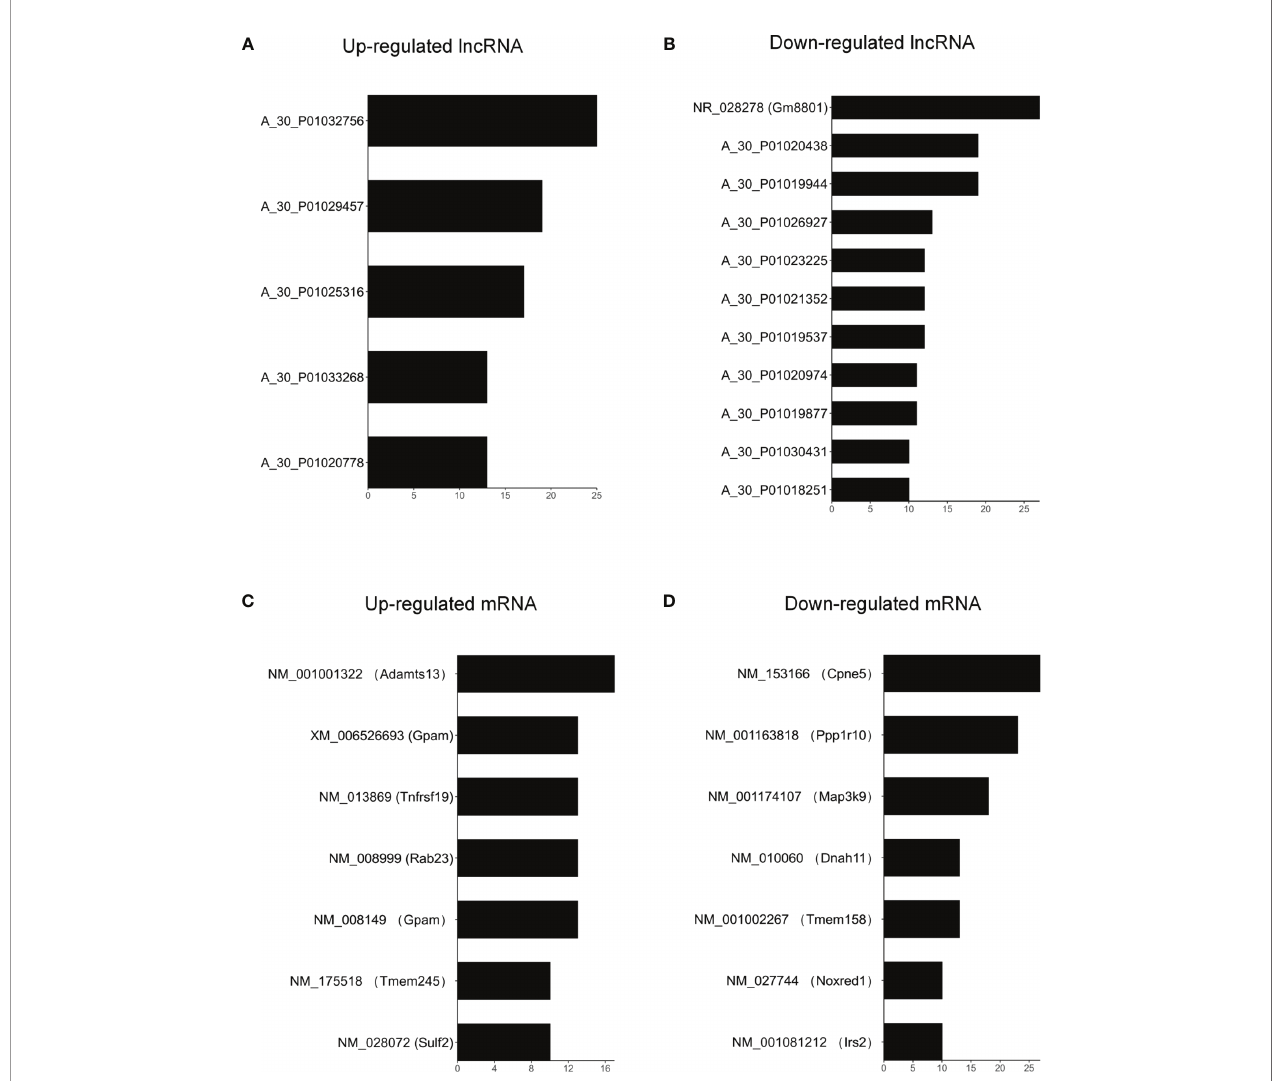
FIGURE 6 | The top correlated lncRNA-mRNA pairs. (A) Up-regulated and (B) down-regulated lncRNAs with correlation degrees > 10. (C) Up-regulated and (D) down-regulated mRNAs with correlation degrees > 10. Correlation levels of 38 lncRNAs and 37 mRNAs were evaluated by correlation degrees in the network. The degree is equal to counts of signi fi cantly correlated lncRNA-mRNA pairs (P < 0.01) involving the corresponding lncRNA or